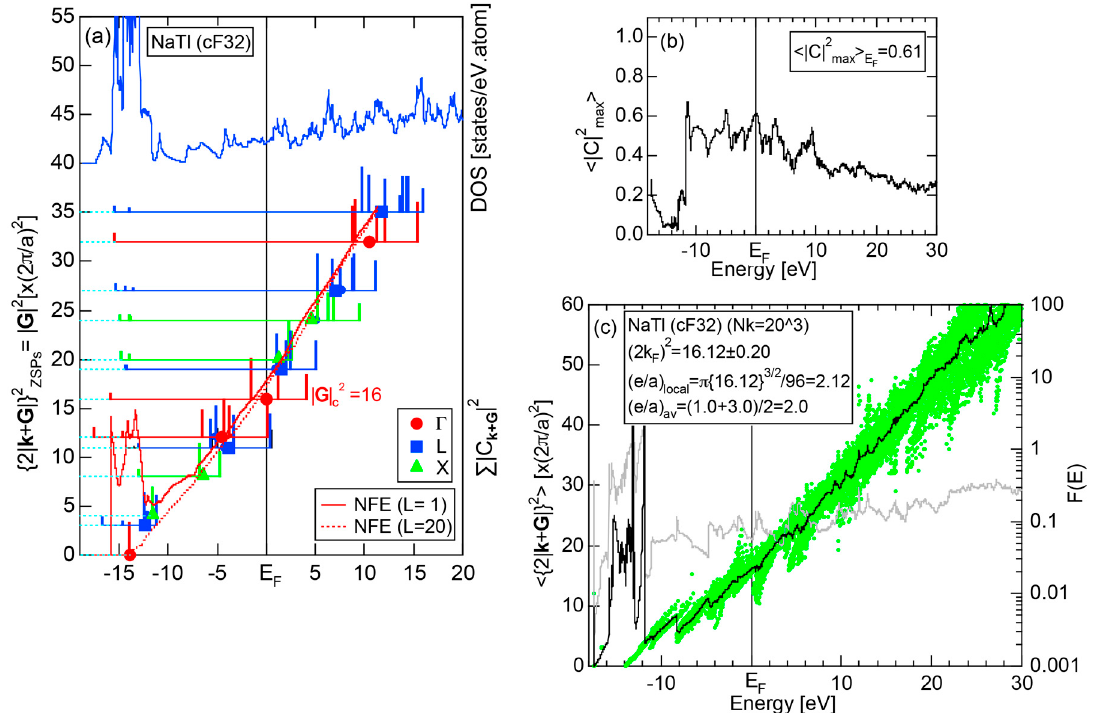
Figure 61. ( a ) FLAPW-Fourier spectra at symmetry points Γ , L, X of the fcc Brillouin zone along with the total DOS; ( b ) C and ( c ) Hume-Rothery plot for NaTl (cF32) [11,41]. See captions of Figure 19 (b) for symbols in ( c ).